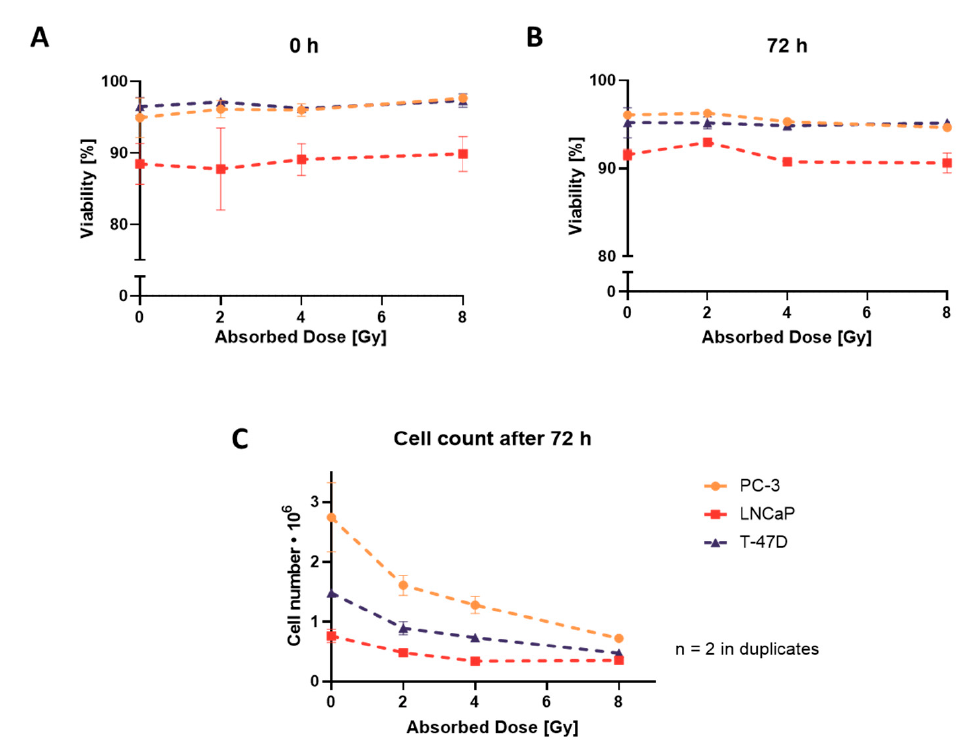
Figure 1. Trypan Blue Exclusion Assay: evaluation of cell viability and proliferation in monolayers. Cell viability immediately (0 h; ( A )) and 72 h ( B ) after irradiation. ( C ) Cell count 72 h after irradiation. ( A – C ) Graphs are plotted as mean ± standard deviation from two independent experiments ( n = 2) performed in duplicates.